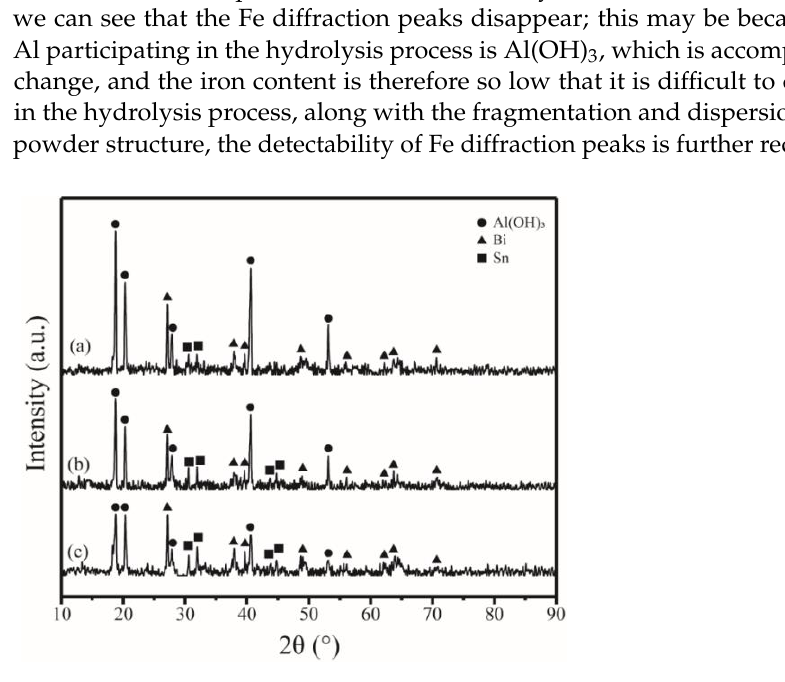
Figure 7. XRD patterns of composite powders after hydrogen generation: ( a ) Al-10Bi-7Sn-0.5Fe (wt.%); ( b ) Al-10Bi-7Sn-1.5Fe (wt.%); ( c ) Al-10Bi-7Sn-3Fe (wt.%). 0.5Fe (wt.%); ( b ) Al-10Bi-7Sn-1.5Fe (wt.%); ( c ) Al-10Bi-7Sn-3Fe